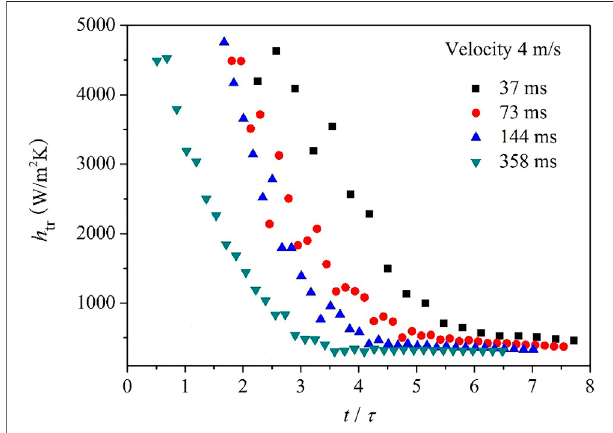
FIGURE 6 | Transient heat transfer coef fi cient at various heat generation periods.